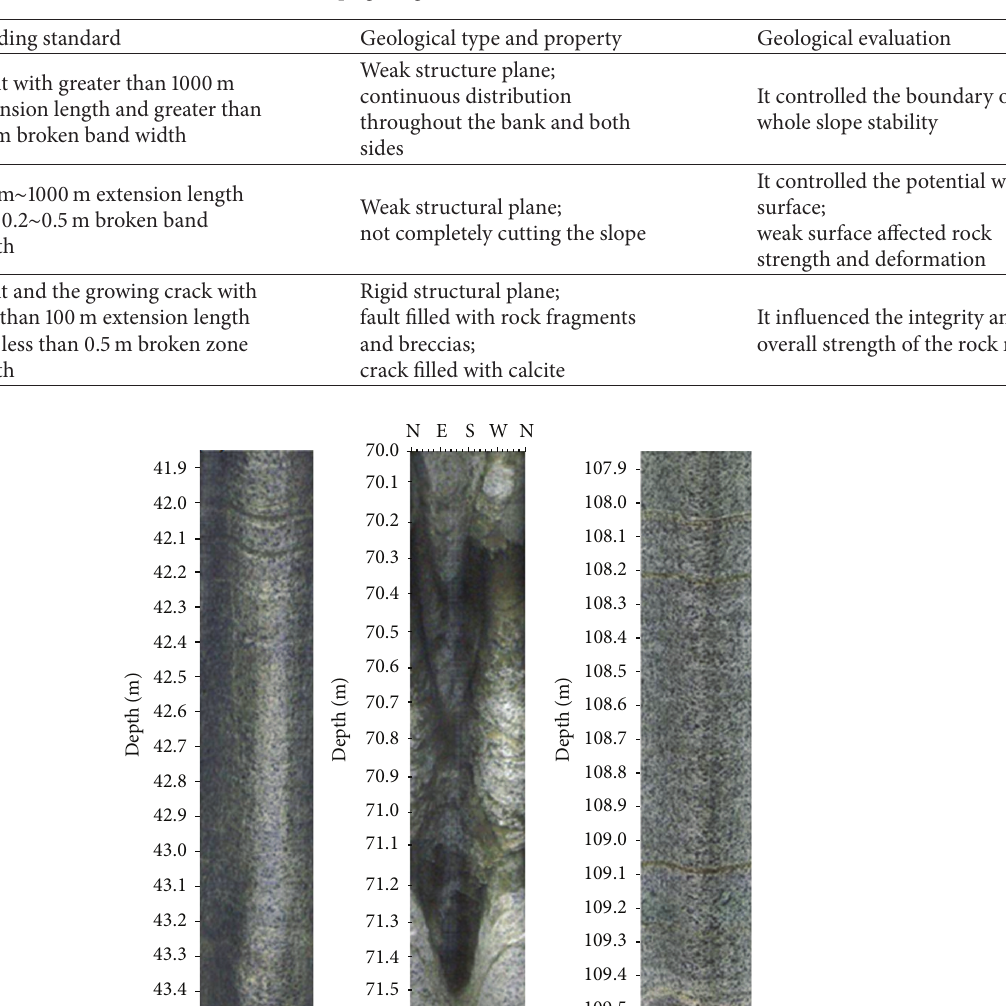
Table 2: Slope geological model for rock mass.